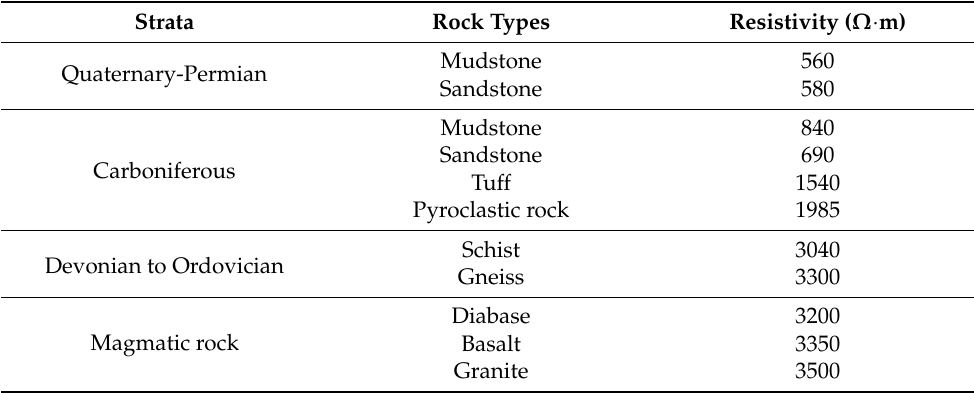
Table 1. Rock physical property parameters in study